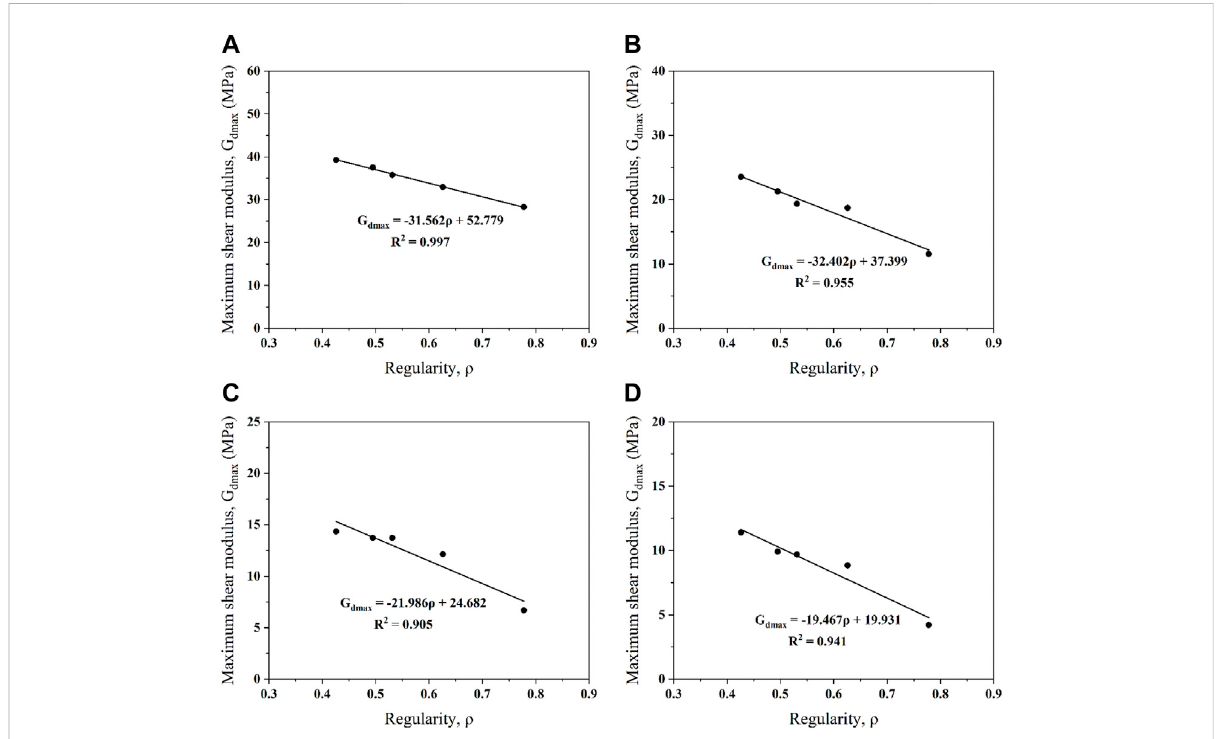
FIGURE 13 Relationshipbetweenthemaximumdynamic shearmodulusandparticleregularityforsamplesunderdifferentshearstrainamplitudes: (A) A γ